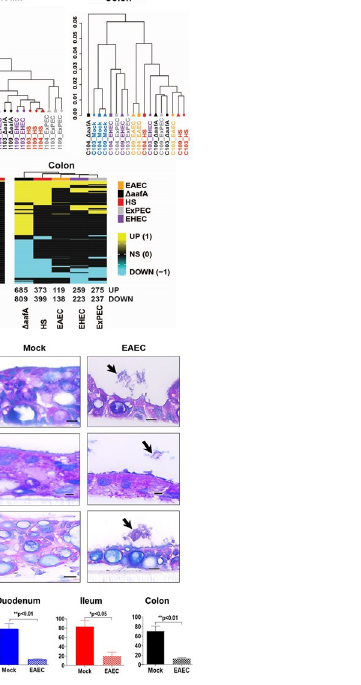
Fig 2. RNA-Sequencing analysis reveals a pathogen-specific differential gene expression signature within different segments of intestine. (A) Hierarchical clustering dendrogram of all gene expression changes using the Pearson correlation coefficient among mock and E . coli infected samples for all four segments of intestine (Duodenum, Ileum, Colon from patients 103, 104 & 109 and jejunum from patient 2, 3 & 11 –see Methods) (B) Samples were hierarchically clustered based on the union of differentially expressed genes across all comparisons (false discovery rate (FDR) < 0.05 and fold change (FC) exceeding 1.5x). Genes were converted to 1 for up-regulated genes and -1 for down-regulated genes and 0 if it a genes were not significant in a particular signature. Samples were clustered used the Euclidean distance. (C) Heatmap showing EAEC infection-specific regulation of Muc gene expression in HIEs. (D) PAS/AB staining of HIEMs infected with EAEC shows epithelial cell damage. The left panel shows the mock-infected epithelial cell layer whereas the right panel reveals epithelial thinning and damage caused by EAEC adherence (EAEC clusters denoted by arrows). (E) Quantification of epithelial thinning caused by EAEC infection. Scale bars indicate 10 μ m. Epithelial thickness was quantified from average of 12 images taken at 100x and with field size of 2560x1920 pixel. Unpaired t-test was carried out, error bars denote SEM and �� indicates significantly different (P < 0.01), � indicates significantly different (P < 0.05).